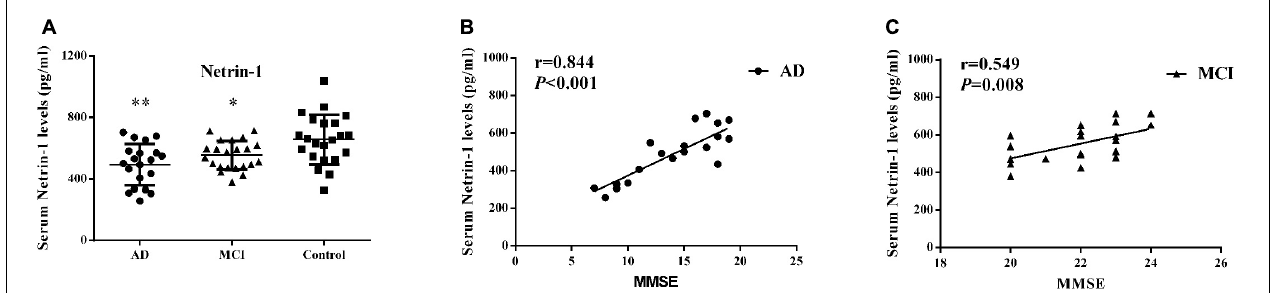
FIGURE 1 | Serum netrin-1. (A) Concentrations of netrin-1 in AD patients, MCI patients and controls. Bar graphs represent the mean ± SD, ∗ P ≤ 0.05 and ∗∗ P ≤ 0.01 versus controls. Correlations between serum netrin-1 levels and MMSE scores in (B) AD and (C) MCI patients.